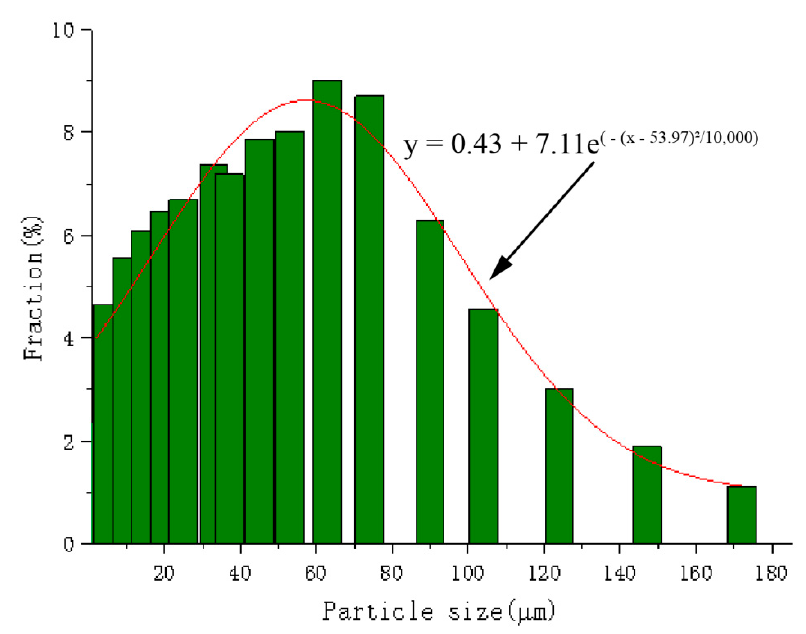
Figure 2. Hydrocyclone separator system experimental configuration.